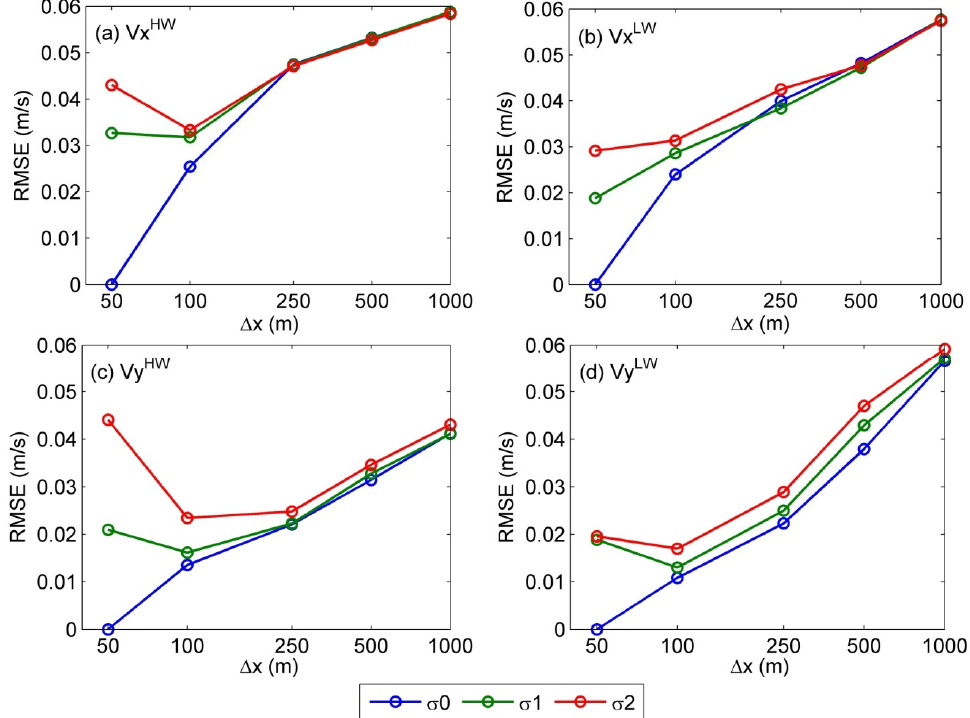
Figure 7. The trade-off analysis of grid-box size and DEM error on water velocities of ( a ) perpendicular direction on high water, ( b ) perpendicular direction on low water, ( c ) parallel direction on high water, and (3) parallel direction on low water along profiles c1-c2 and d1-d2 in Figure